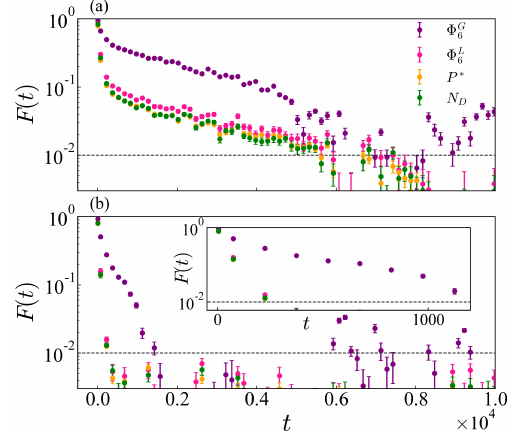
Figure 2. The typical decaying process at (a) ν = 0 . 708 and (b) 0 . 720 are shown, respectively. These data are obtained by averaging over a dozen sampling numbers within a certain short time. The inset of (b) shows a wide view at the early stage of decay. A distinct di ff erence between them can be observed that all physical properties in (a) decays much slower than